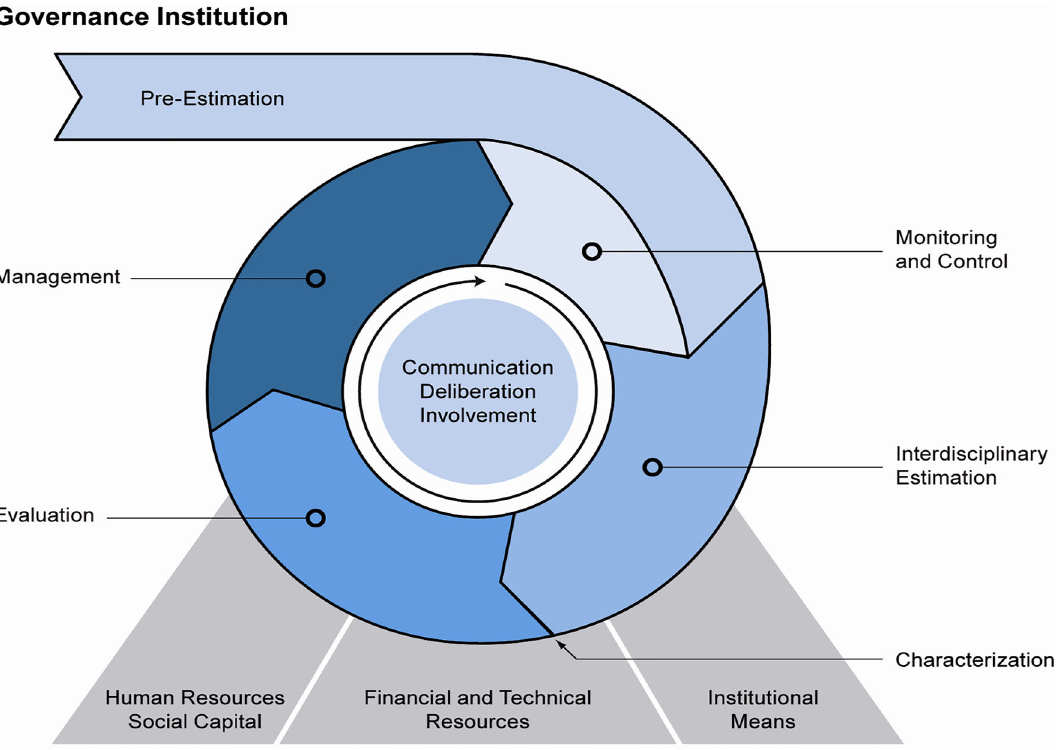
Fig. 1 Adaptive and integrative risk governance model adapted from Klinke and Renn (2012) [The adaptive and integrative risk governance model is based on a modification and refinement of the IRGC framework (IRGC